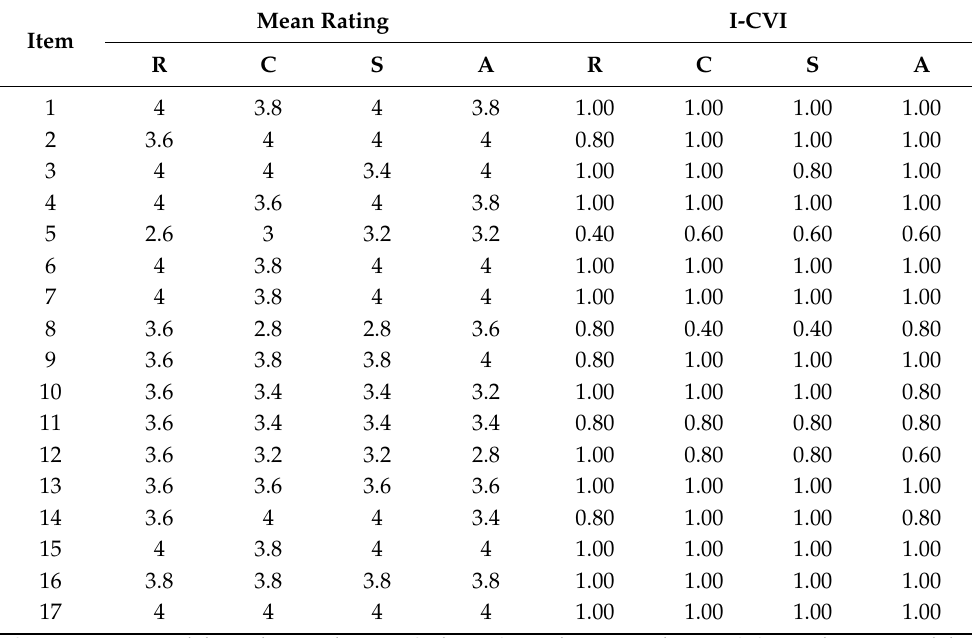
Table 2. Item rating and content validity index of the first questionnaire